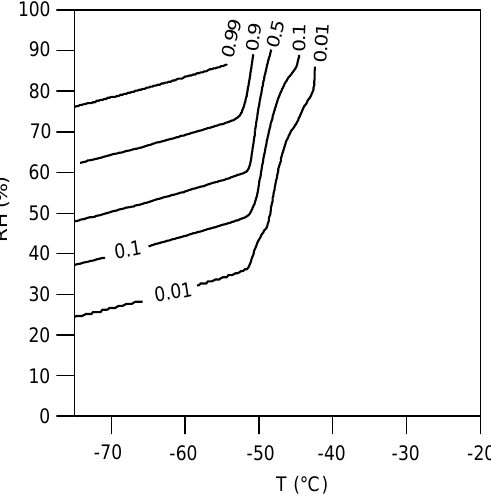
Fig. 6. Maximum possible fractional coverage of persistent contrails, b PC , for ECHAM level 7, as a function of the state variables temperature, T , and relative humidity, RH . The corresponding function for ECHAM level 8 is link between the large-scale meridional temperature gradient and the Lorentz distribution.